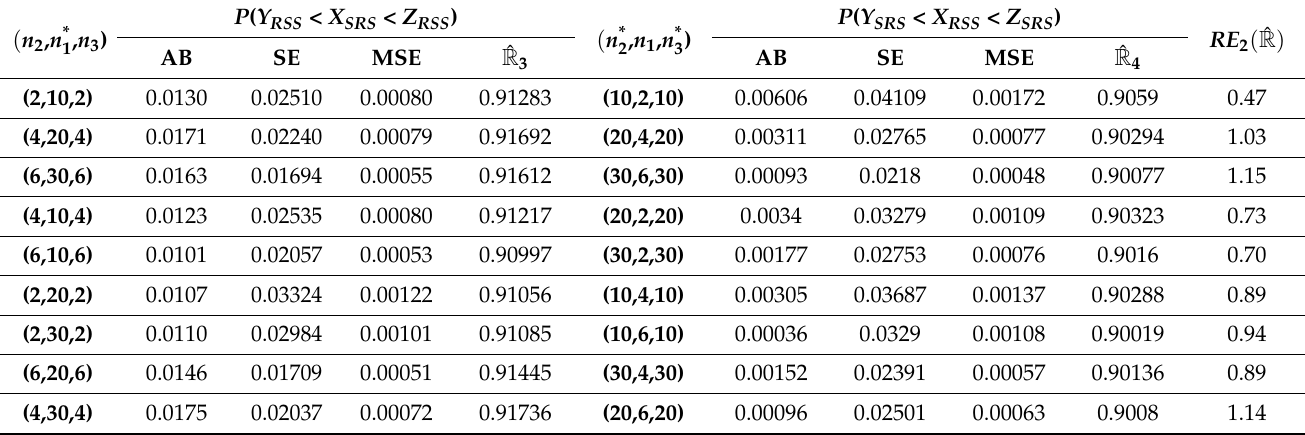
Table 2. Measurements of ˆ R 3 and ˆ R 4 for sampling schemes at R = 0.9 and d =